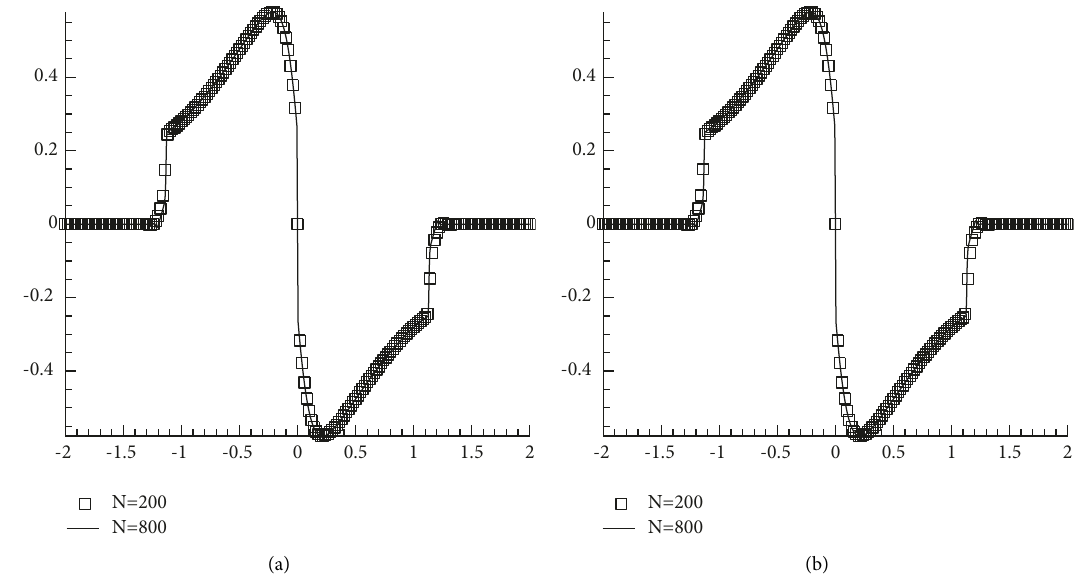
Figure 6: Example 6. Riemann problem. T � 0.7. CRUS-WENO scheme (a); WENO-JS scheme